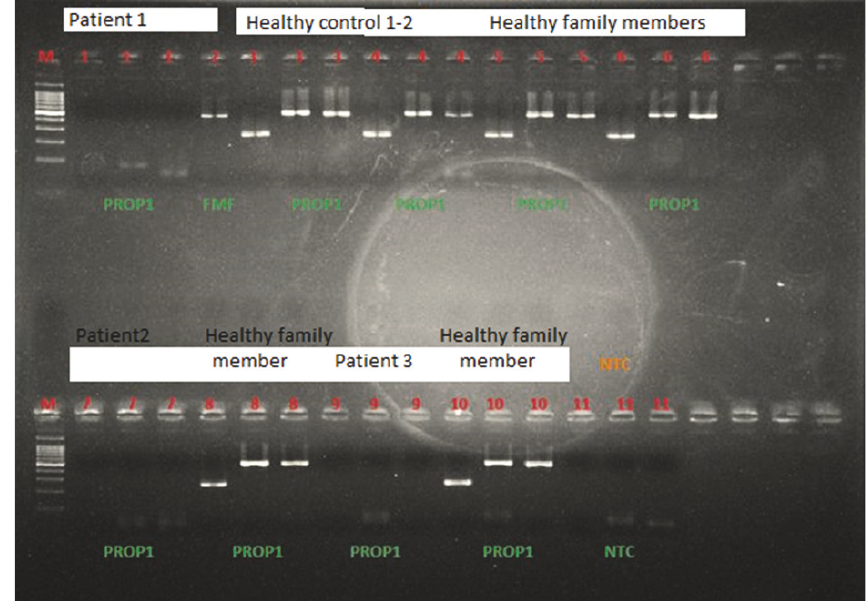
Figure 1: Three patients showed no amplification in PROP1 locus, whereas reference gene (Mediterranean fever-MEFV) was amplified. Healthy controls and healthy family members showed successful amplifications